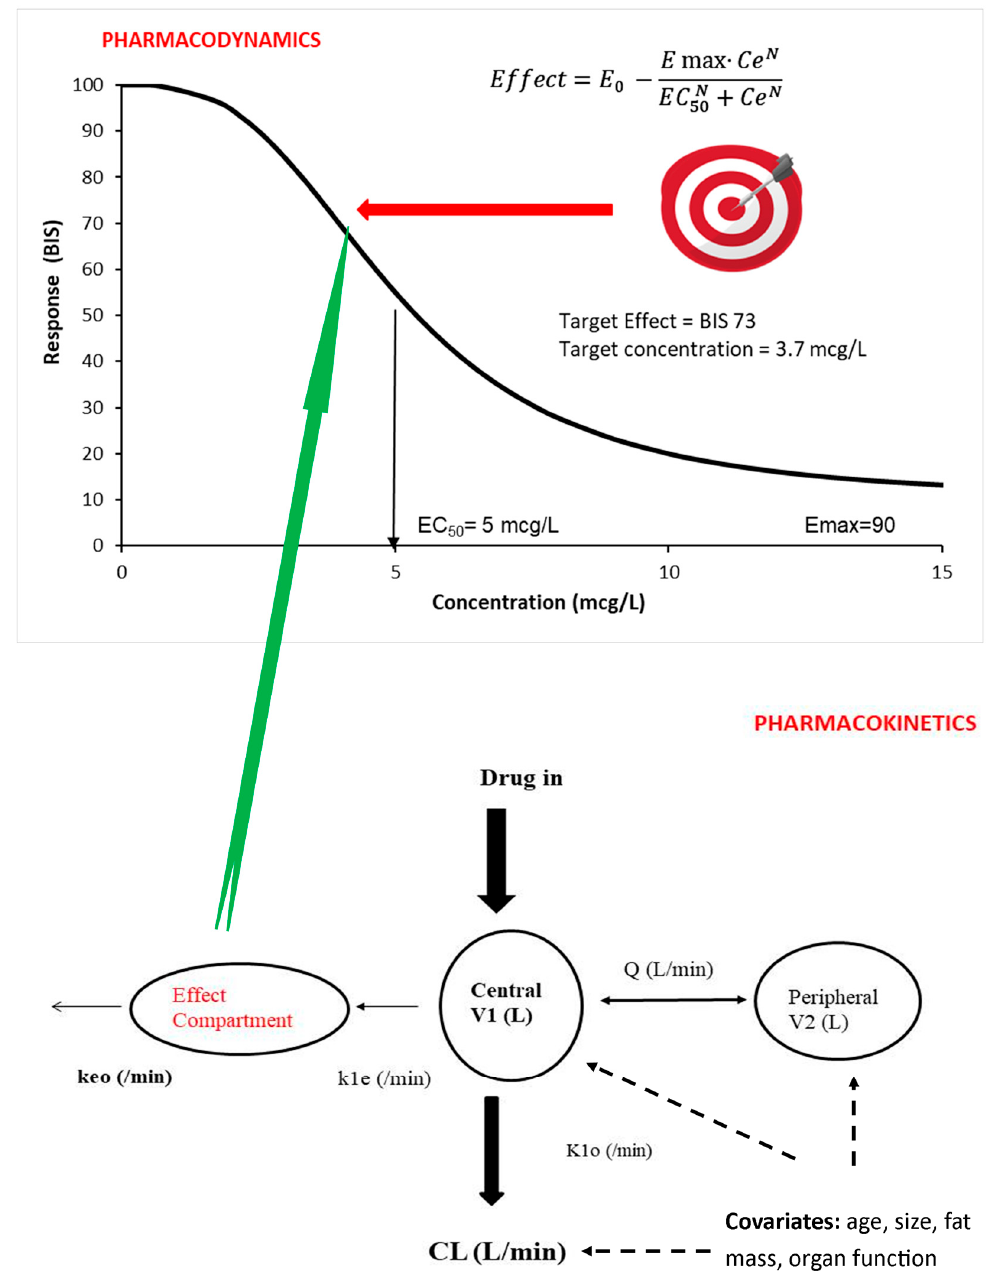
Figure 1. Principles behind the target concentration strategy are shown diagrammatically. The upper panel shows a concentration response for a drug with sedative properties. The shape of this response is determined using the E MAX equation. Light sedation is associated with a bispectral index (BIS) of 73. This target effect is associated with a target concentration of 3.7 µg/L. Pharmacokinetic knowledge (lower panel) is then used to achieve this target concentration in the effect compartment (Ce). A 2-compartment pharmacokinetic model is shown in this example. Concentration in the central compartment (Cp) is linked to that in the effect compartment by a rate constant (k1e = keo at steady-state).